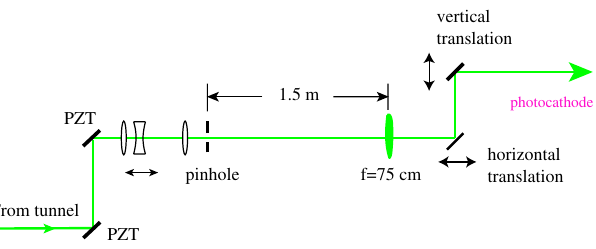
FIG. 17. Layout of the optical table near the electron gun.